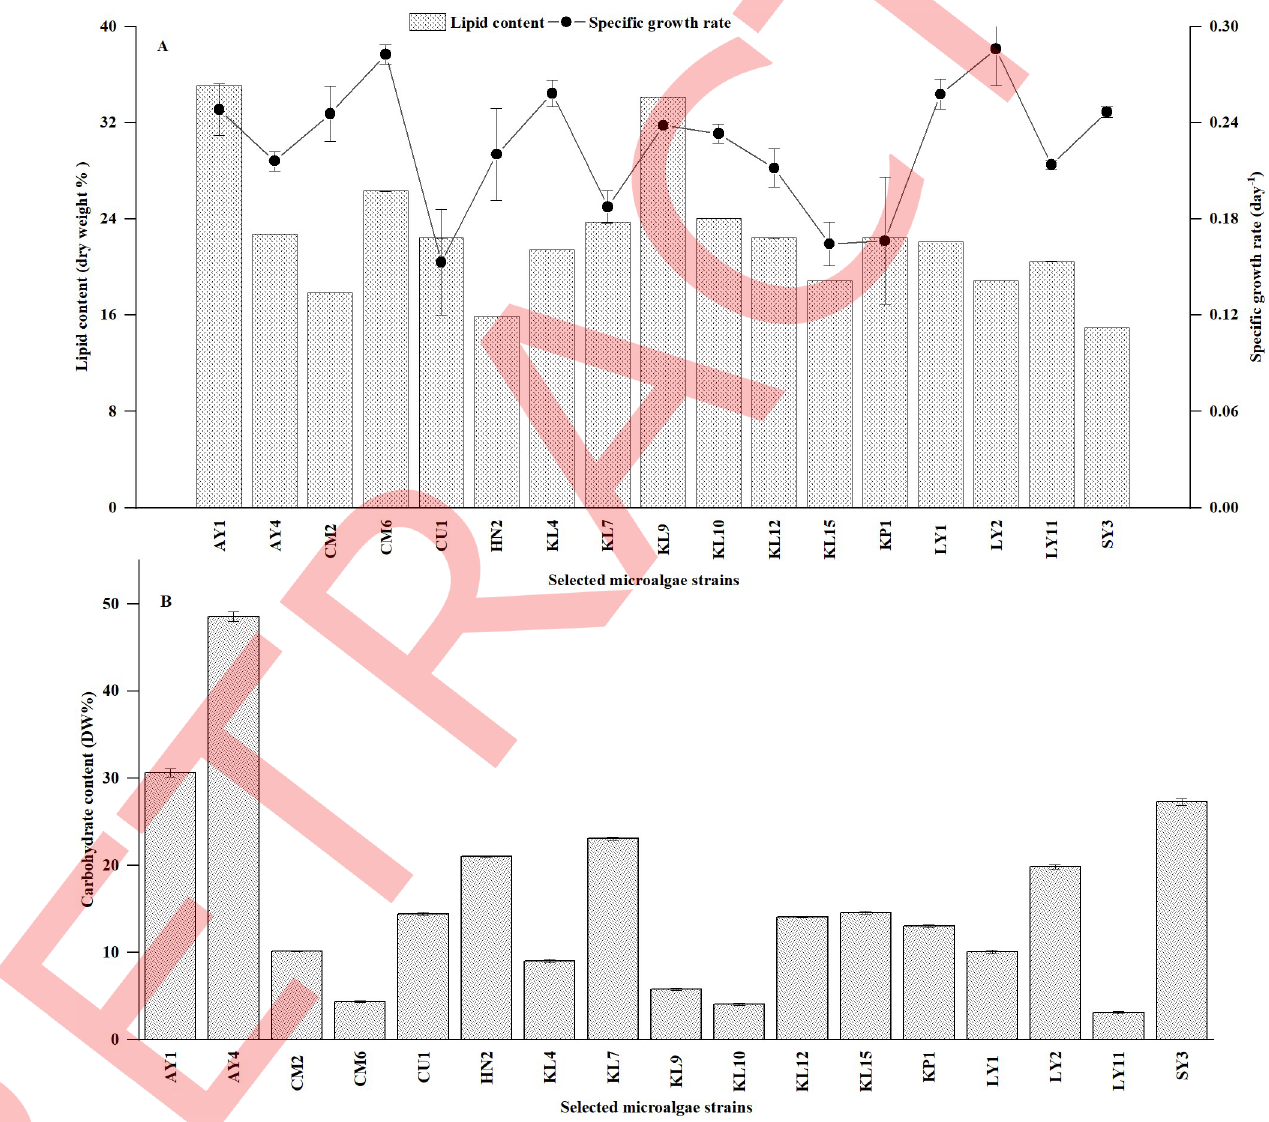
Fig 4. Gravimetric lipid content and specific growth rate (A) and Carbohydrate content (B) of the selected microalgae strains under mesophilic growth conditions. Error bars indicate standard deviations of the replicate values for each strain.